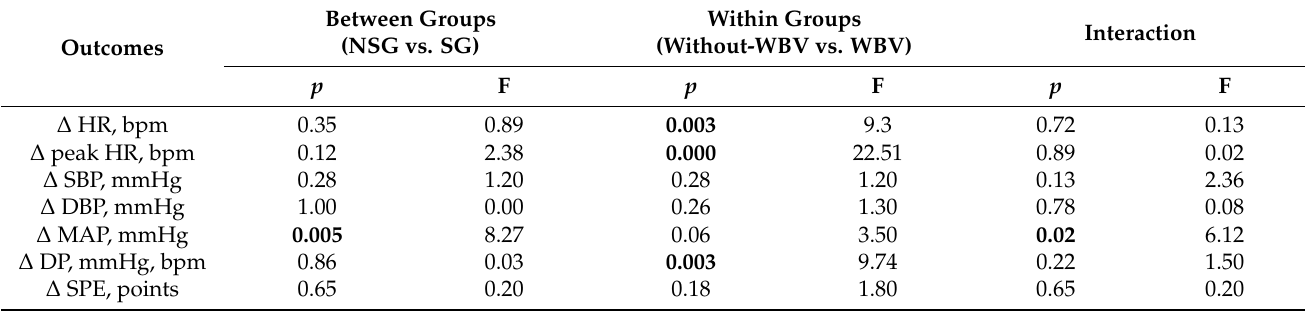
Table 3. Effects and interaction values found by Two-way ANOVA analysis of the data presented in Table 2. Between Groups Within Groups (NSG vs. SG) (Without-WBV vs. Outcomes